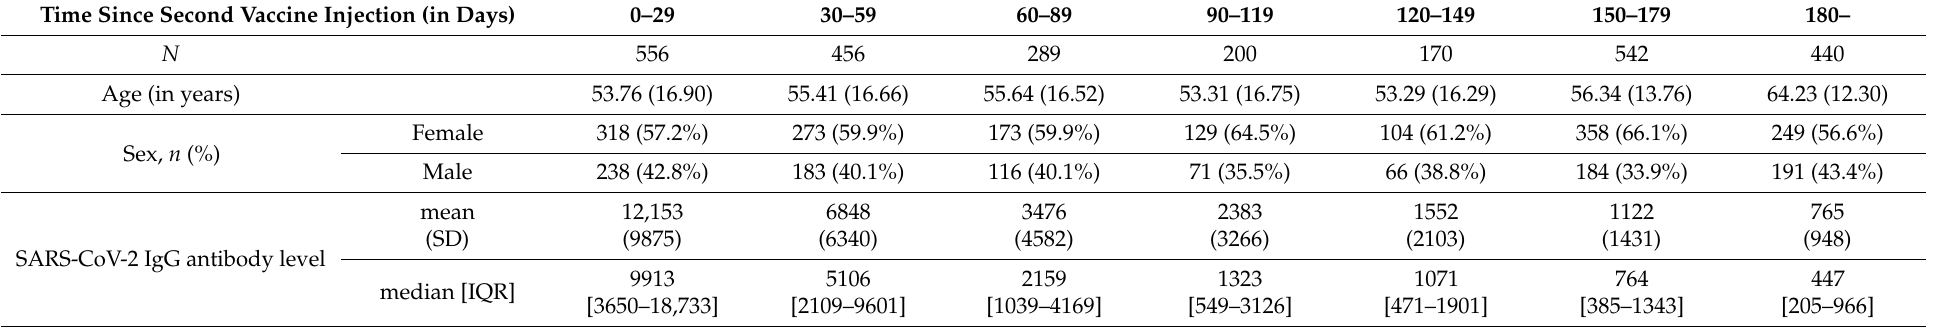
Table 2. Serology results of vaccinated individuals by 30 days intervals since second vaccination.